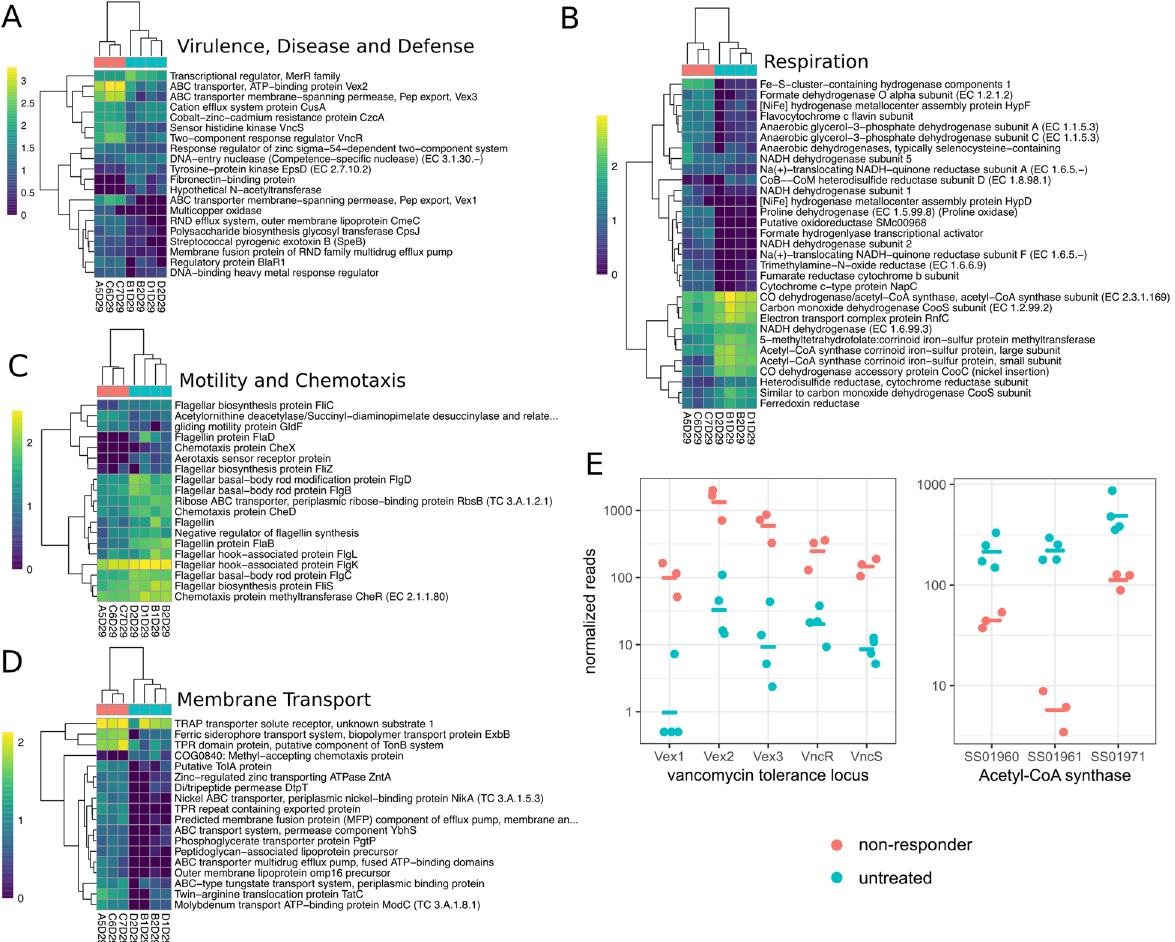
Fig. 5 Differentially abundant pathways in non-responder phenotypes. A – D Heatmaps showing differentially abundant (FDR < 0.05) functional groups grouped by SEED superpathway. Heatmap color scale shows normalized reads on a log10 scale with a pseudocount of 1. Sample names in the columns are a combination of the individual mouse identi fi ers (e.g. A5 refers to the fi fth replicate mouse in the treatment group A) and the day the sample was taken (e.g. D29 refers to day 29). Colors on top of the columns denote response type (red = non-responder, blue = controls). E Normalized expression of genes on the vancomycin tolerance locus and three Acetyl-CoA synthase genes between non-responders and controls.